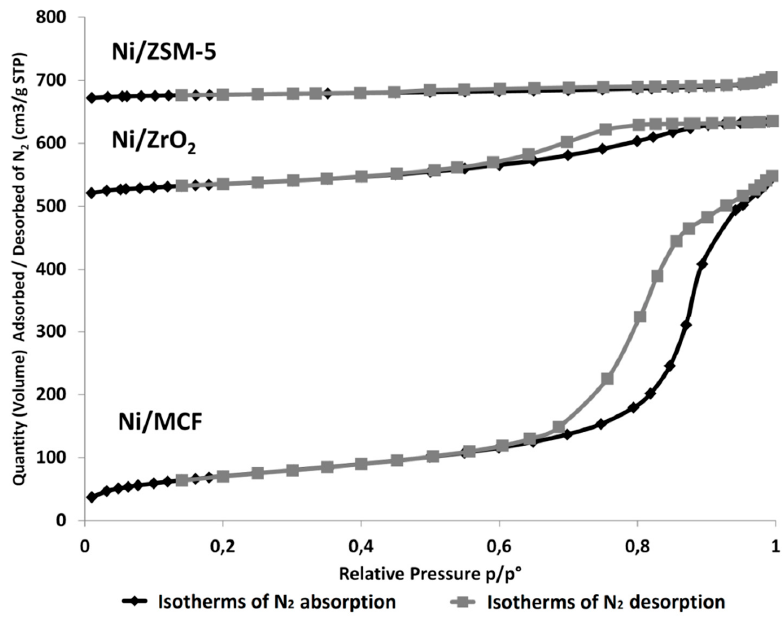
Figure 1. N 2 adsorption / desorption isotherms obtained for Ni / MCF, Ni / ZrO 2 , and Ni / ZSM-5